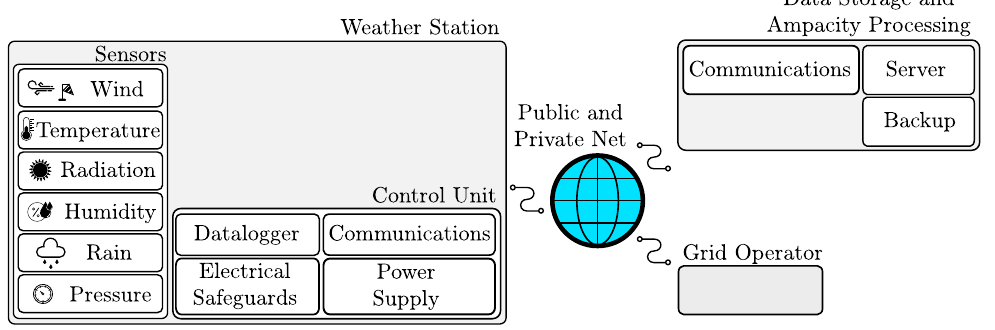
Figure 2. Architecture of ampacity management